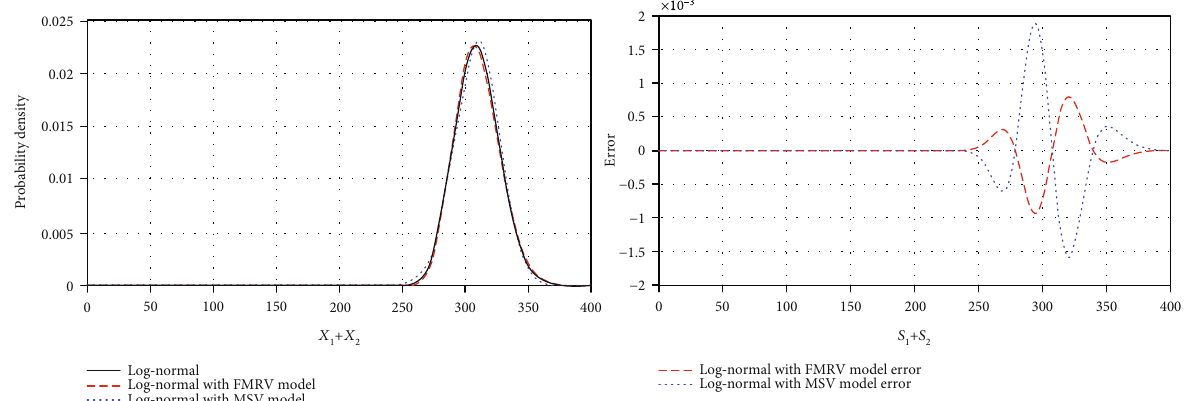
Figure 2: Di ff erence of probability density function and